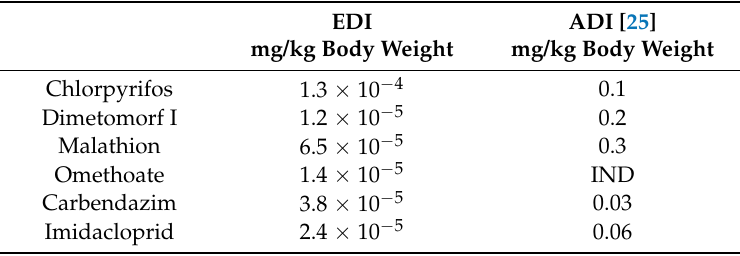
Table 5. Comparison of the results of estimated daily intake (EDI) with the admitted daily intake (ADI) for pesticide residues detected in Nopal in the state of